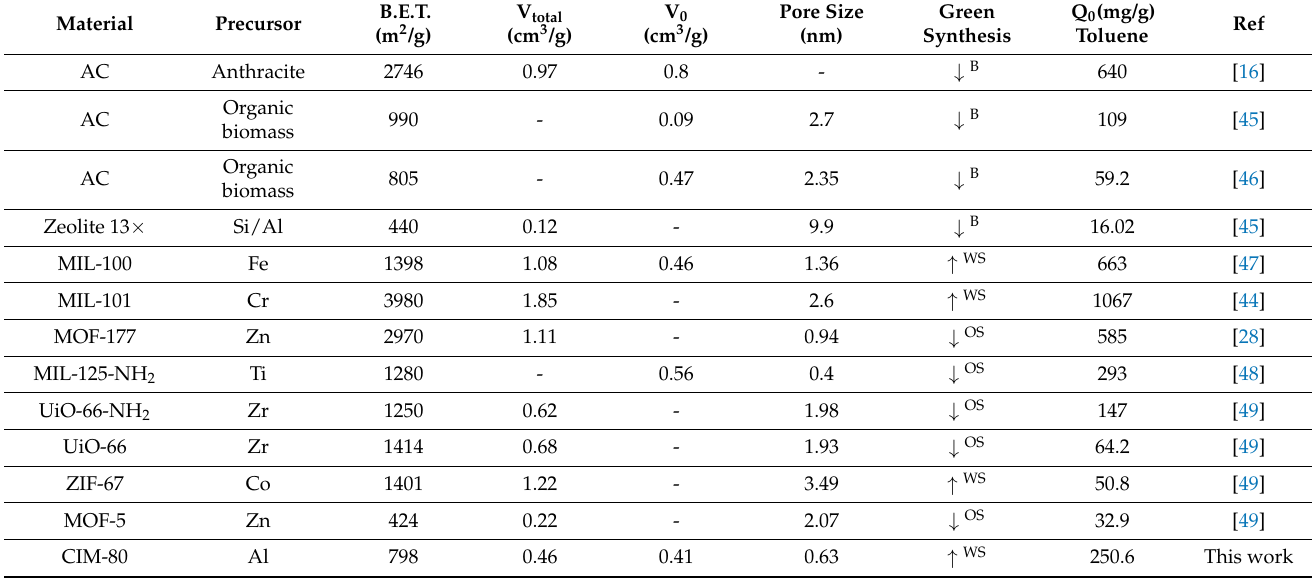
Table 5. Toluene adsorption capacities: comparison CIM-80 with other